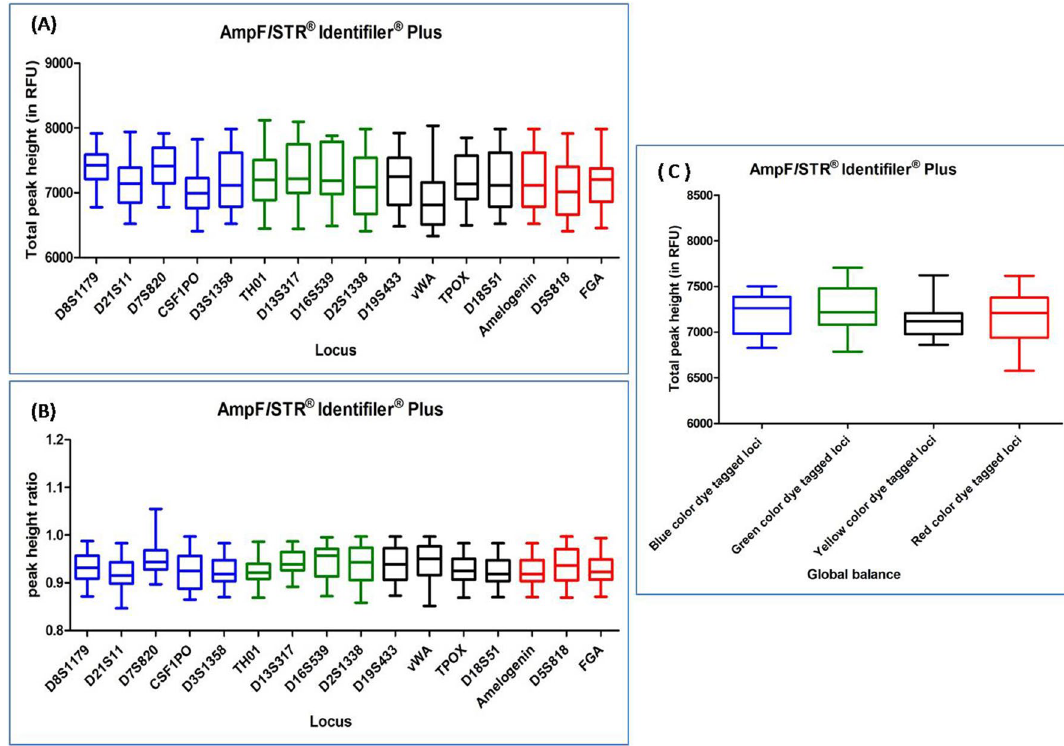
Figure 3. Quality assessment of DNA profile by Dunn’s multiple comparison test for the AMPF L STR IDENTIFILER PLUS PCR AMPLIFICATION KIT ( A ) Total peak height ( B ) Peak height ratio ( C ) Global balance.